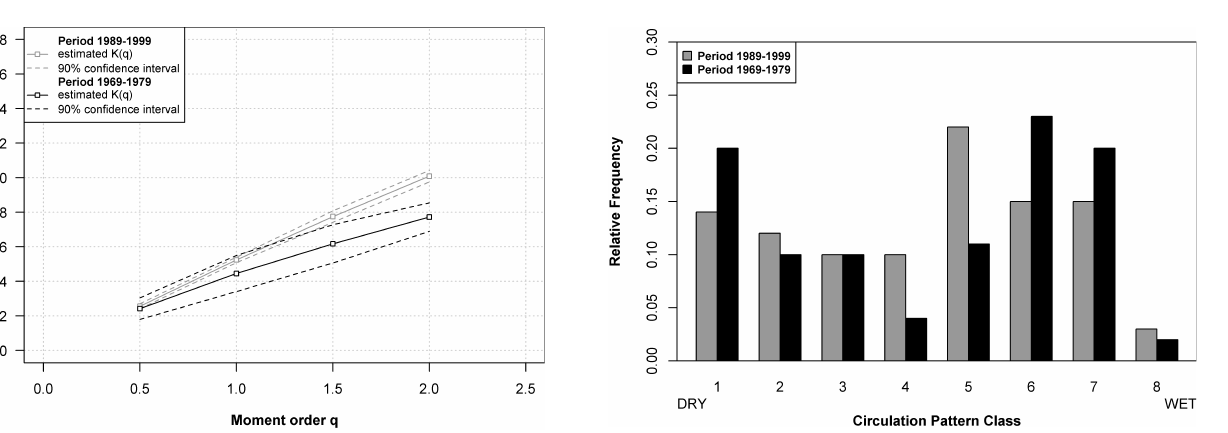
rainfall events with greater variability covered by this